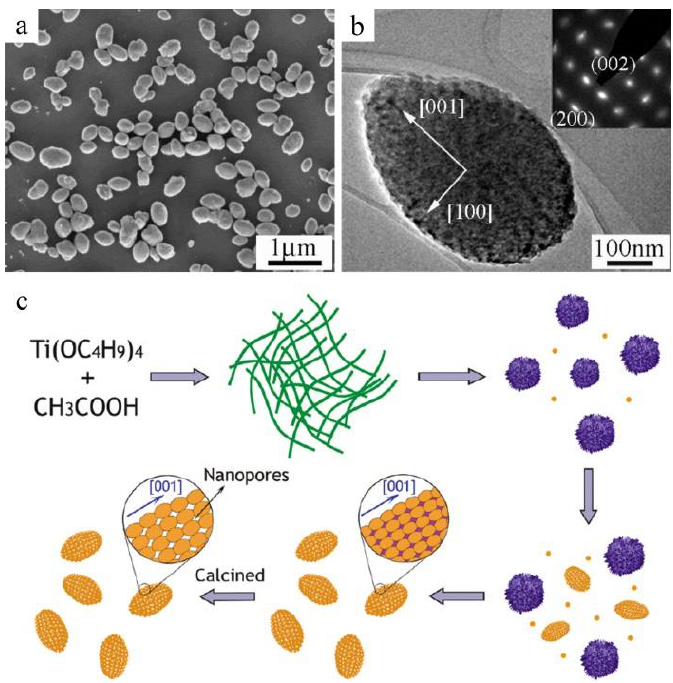
Figure 8. ( a ) SEM and ( b ) TEM images of nanoporous anatase TiO 2 mesocrystals obtained